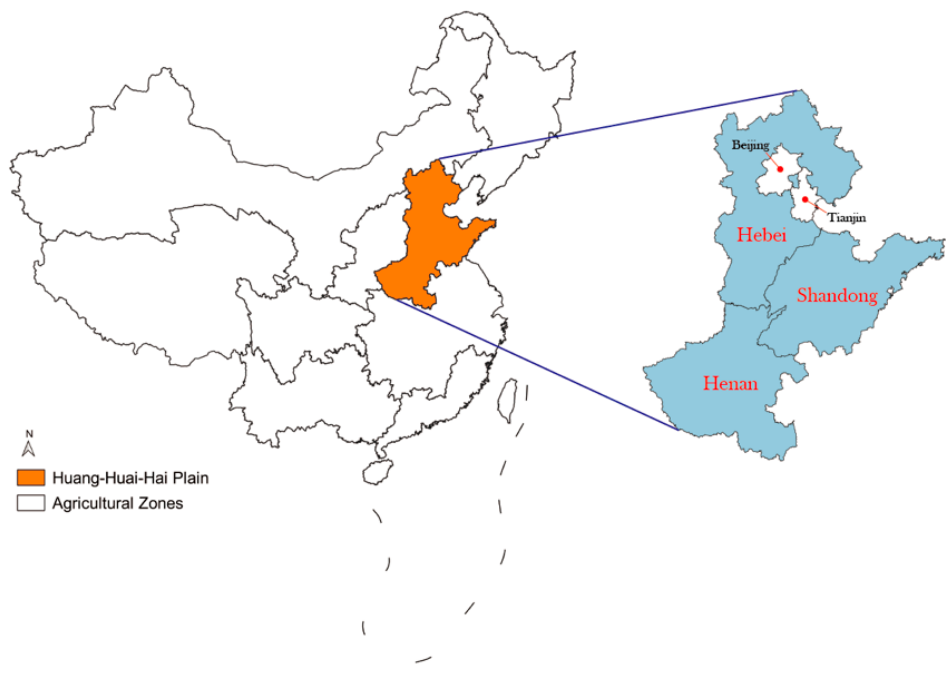
Figure 1. The geographical location of the study areas.